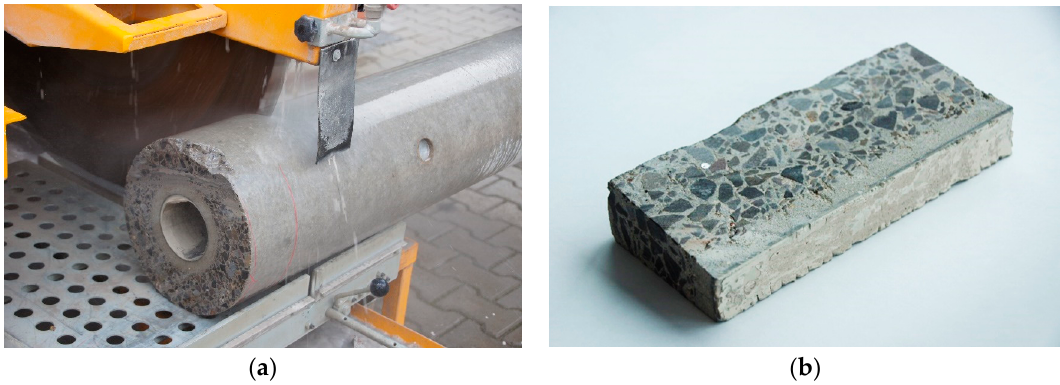
Figure 2. Preparation of test samples: ( a ) cutting off the top of the pole; ( b ) a slice of concrete intended for laboratory testing.